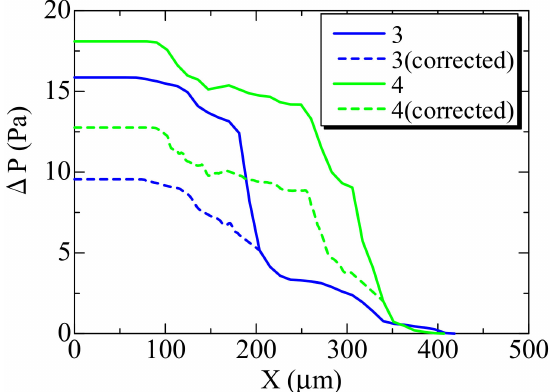
Figure 12. Distribution of pressure of corrected substrates in samples 3 and 4, together with other